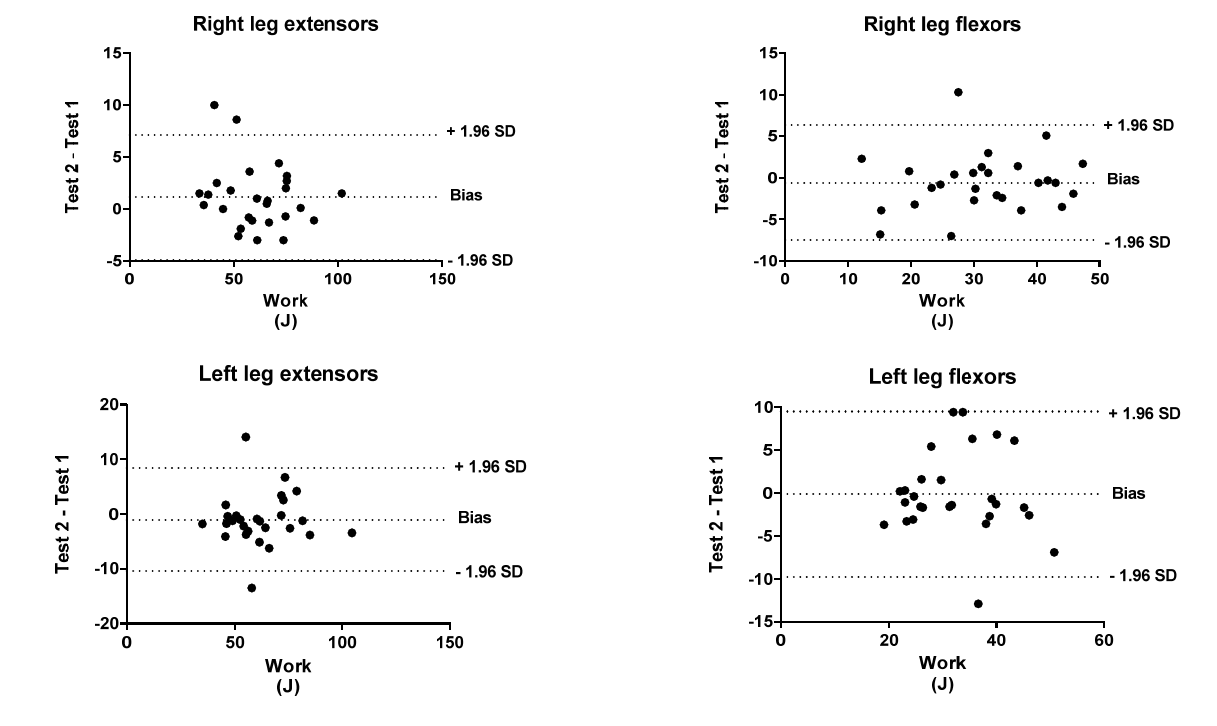
Figure 4. Women Bland–Altman work analysis for Right and Left Legs in flexion and Extension.